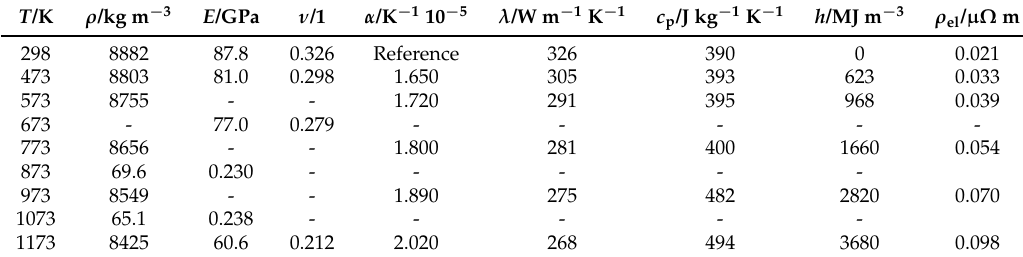
Table A3. Thermophysical properties of CuCr1Zr.